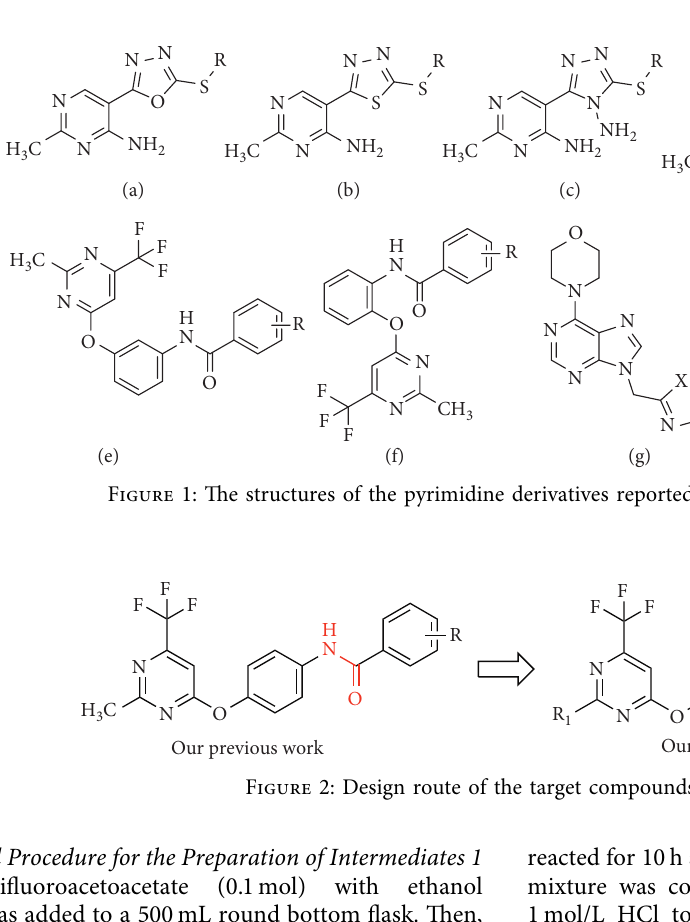
Scheme 1: Synthetic route for the target compounds 4a – 4q .